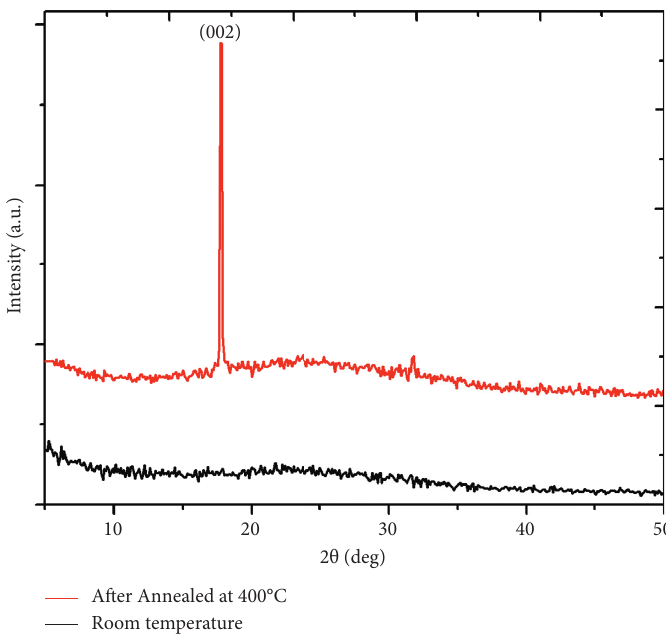
Figure 2: XRD plot of V 2 O 5 at room temperature. Table 1: The grain size of the thin films.